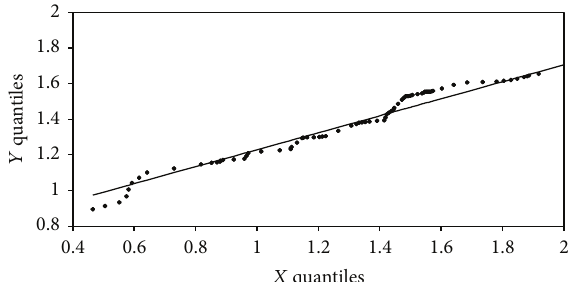
Figure 6: Quantiles-Quantiles ( 𝑌 -Simulation, 𝑋 -observations) with seasonal mean amounts for Turnu Magurele station.